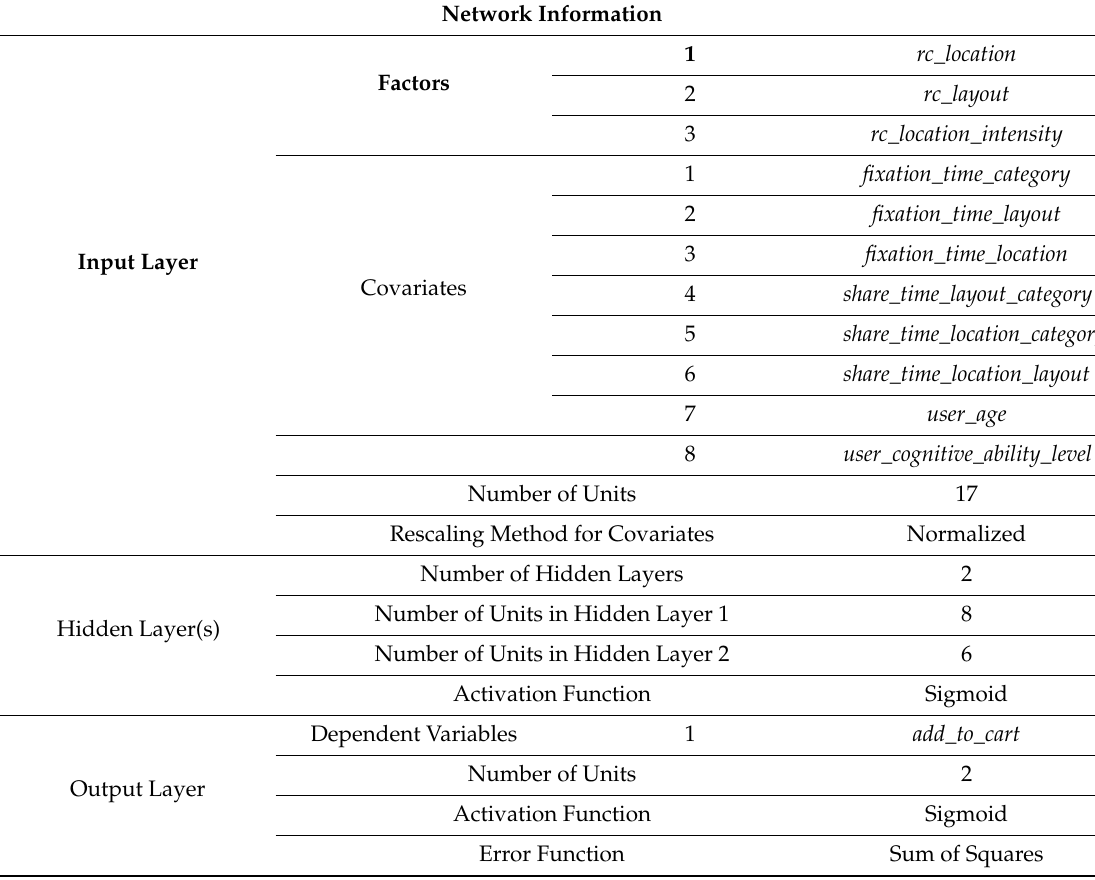
Table 3. Parameters of multilayer perceptron neural network.